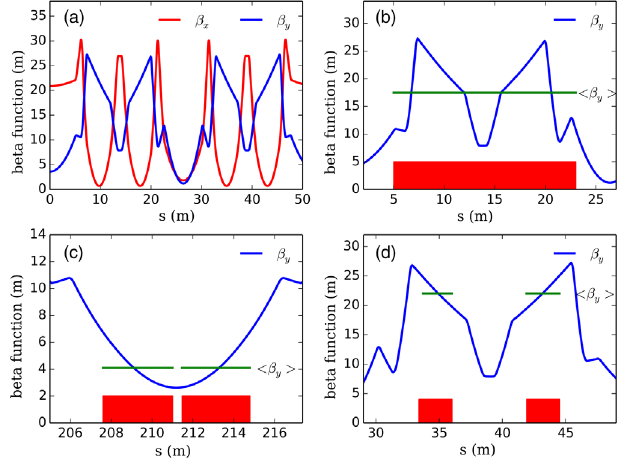
FIG. 1. (a) One superperiod of the NSLS-II DBA lattice consisting of two cells with short and long straight sections. Vertical beta function (magenta trace) variation and its average (green trace) over the length of the impedance element (red rectangle): (b) aluminum vacuum chamber in the first half superperiod; (c) DWs in cell 8; (d) bending magnet chamber in cell